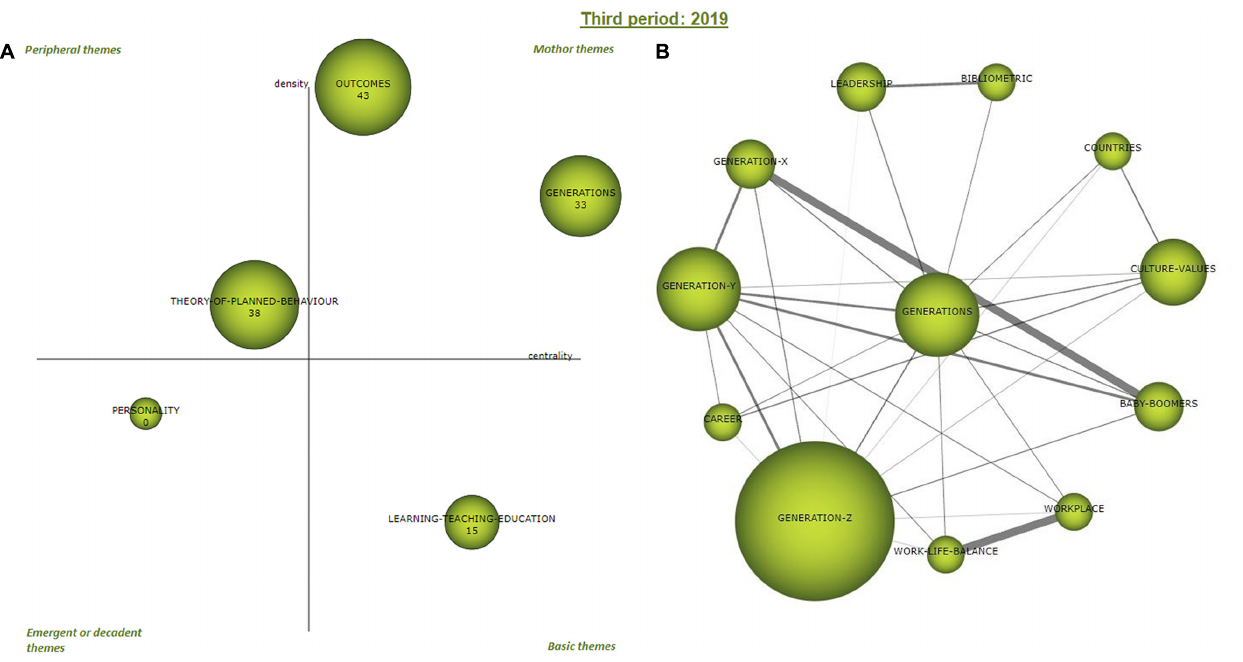
FIGURE 7 | Period 2019 strategic diagram (A) and motor cluster’s network (B) . Source: elaborated with SciMAT.